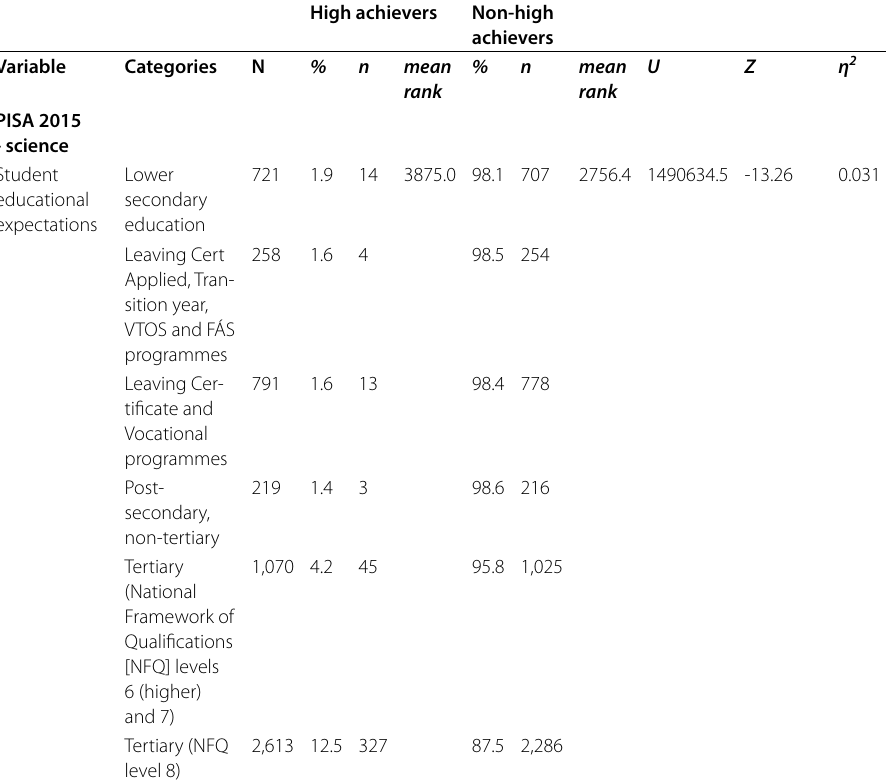
Table 2 Distribution of students across ordinal background variables